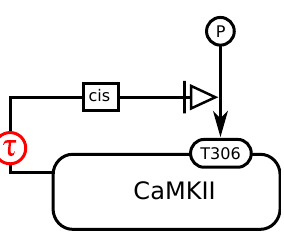
Figure 2.10: Example of the delay logical operator, showing that the stimulation of the phos- phorylation of CaMKII on threonin 306 takes place a measurable amount of time after the decision of stimulation is